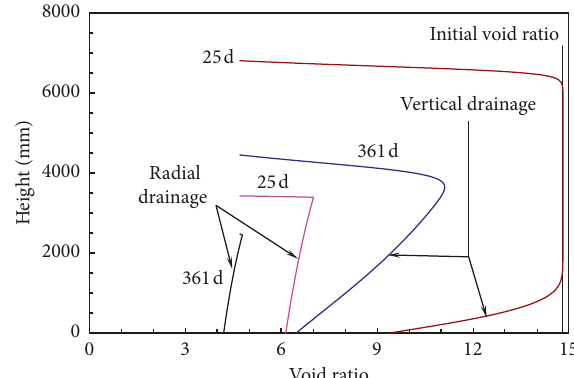
Figure 8: Curve of the void ratio along soil height under different consolidation time.